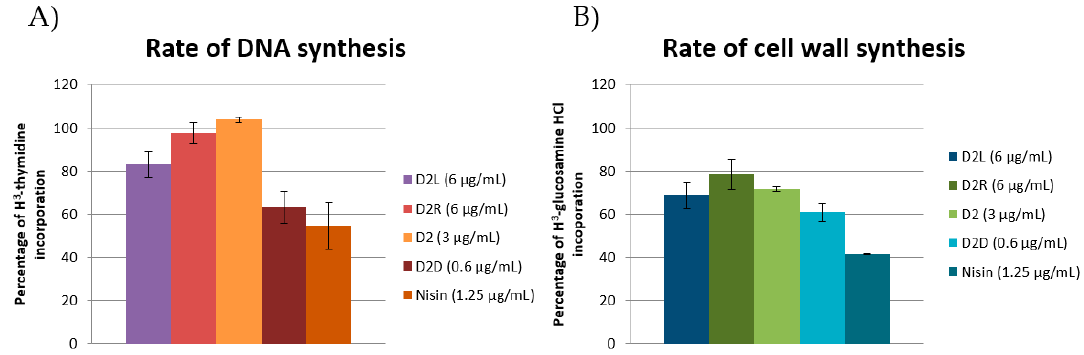
Figure 5. Effect of sub-MIC concentration of AMPs on macromolecule biosynthesis. A ) Effect on DNA and B ) cell wall synthesis in cells treated with sub-MIC concentrations (0.5× MIC) of D2D , D2L , and D2R after 20 min of incubation. The peptide nisin was used as control. Data are represented as means of two repeated experiments ± SEM.